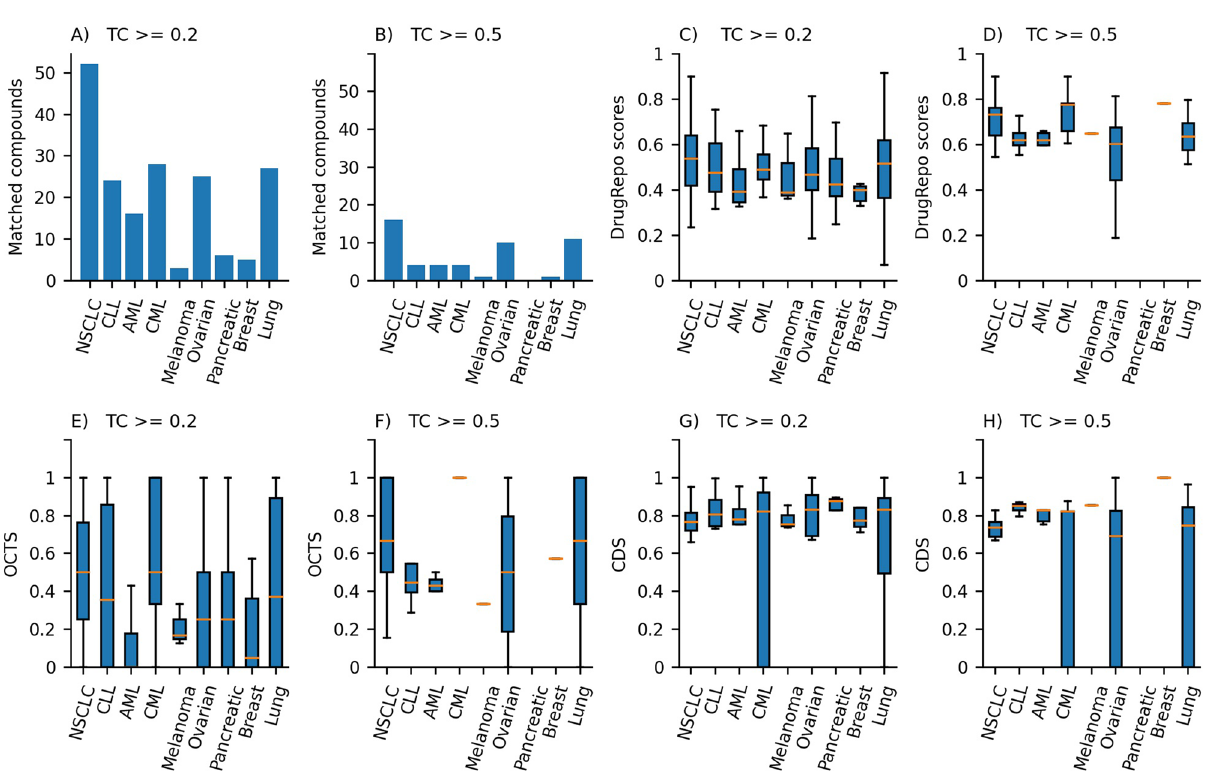
Figure 6. ( A ) The number of matched candidate compounds across nine cancer types using structural similarity (TC) ≥ 0.2, ( B ) Number of matched candidate compounds using structural similarity (TC) ≥ 0.5, ( C ) Distribution of DrugRepo scores for matched compounds for structural similarity (TC) ≥ 0.2, ( D ) Distribution of DrugRepo scores for matched compounds for structural similarity (TC) ≥ 0.5. ( E ) Distribution of compound- disease score for repurposed compounds TC ≥ 0.2, ( F ) Distribution of compound-disease score for repurposed compounds TC ≥ 0.5, ( G ) Distribution overlapping target profile scores between approved and repurposed compounds TC ≥ 0.2, ( H ) Distribution overlapping target profile scores between approved and repurposed compounds TC ≥